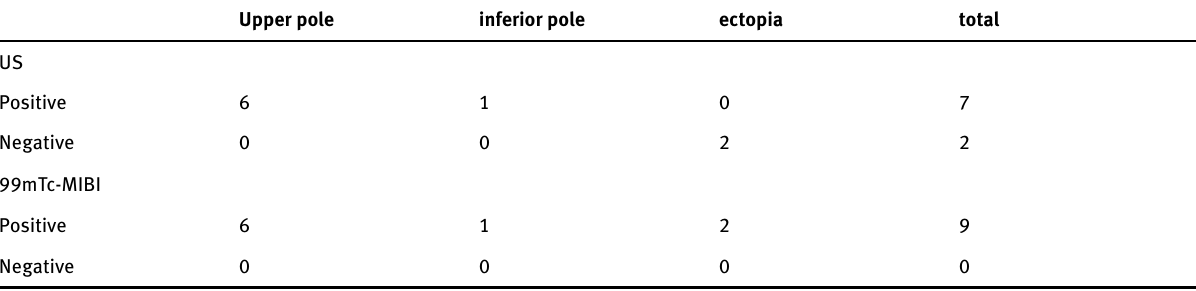
Table 3 Comparison of the number of superior and inferior parathyroid glands and inferior heterotopic parathyroid glands tested by US and